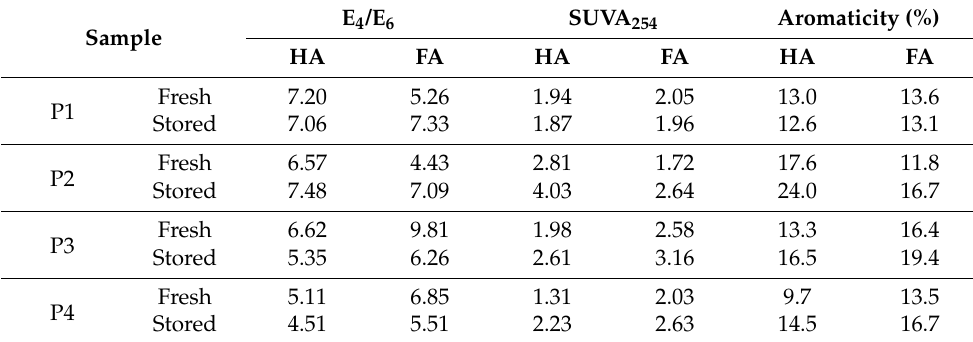
Table 3. E 4 /E 6 ratios, SUVA 254 , and % aromaticity of HA and fulvic acids (FA) extracted from fresh and stored sewage sludge